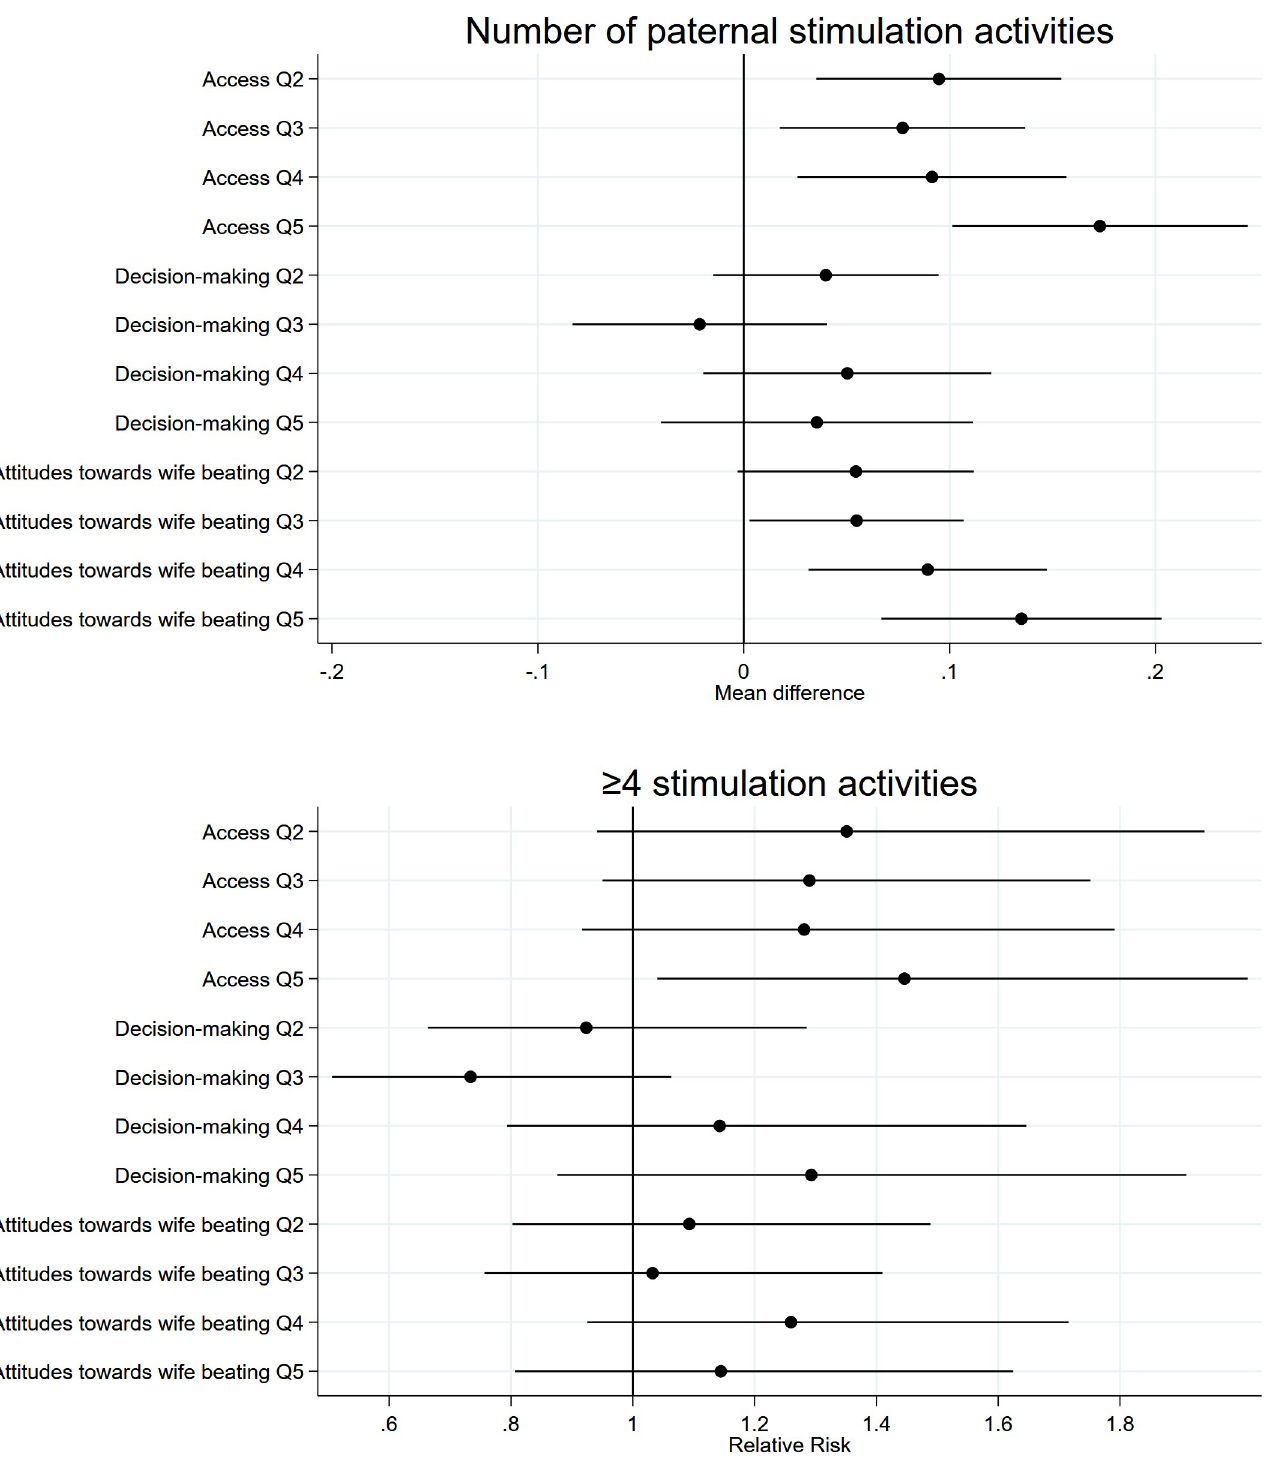
Fig 5. Associations between quintile categories of women’s empowerment dimensions and paternal stimulation outcomes. All estimates accounted for clustering and representativeness using country-specific cluster variables and sampling weights and controlled for household wealth, rurality, and size; household head’s age and sex; maternal education, age, and age at first cohabitation; child age and sex; and country and survey year. Reference quintile category is Q1, lowest. Q, quintile category.